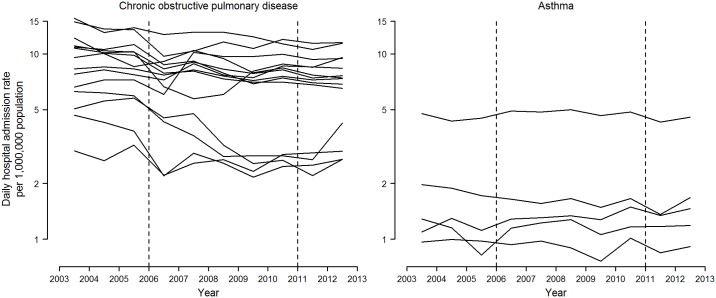
Daily hospital admission rates for chronic obstructive pulmonary disease and asthma by single calendar year in selected Spanish provinces, 2003–2012.Average daily admission rates for each calendar year were obtained from overdispersed Poisson additive models with single-year indicators and adjusted for seasonality, day of the week, temperature, influenza epidemics, acute respiratory infections, and pollen counts for asthma-related admissions (only available in Asturias, Barcelona, Madrid, Murcia, and Zaragoza). Rates refer to 1,000,000 population ≥ 18 years for cardiovascular diseases, ≥ 40 years for chronic obstructive pulmonary disease, and all ages for asthma. Vertical dashed lines represent the dates at which the partial and comprehensive smoking bans entered into force on January 1st, 2006, and January 2nd, 2011, respectively.